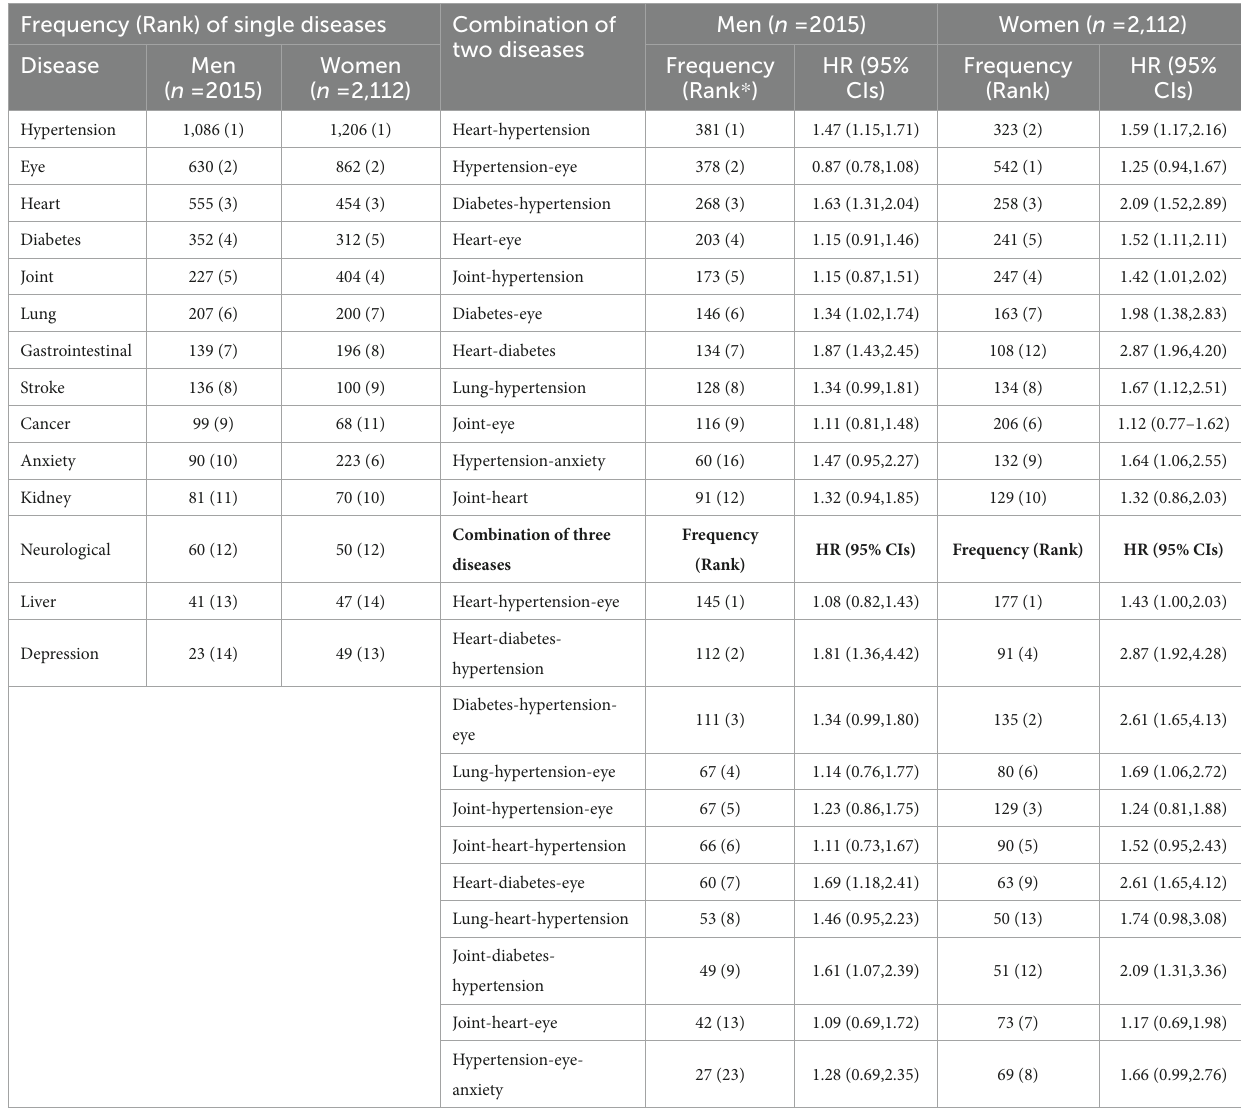
TABLE 4 Frequency of single disease and the most prevalent combination of two and three diseases and their corresponding adjusted hazard ratios (95% confidence interval) for all-cause mortality stratified by sex. Frequency (Rank) of single diseases Combination of two